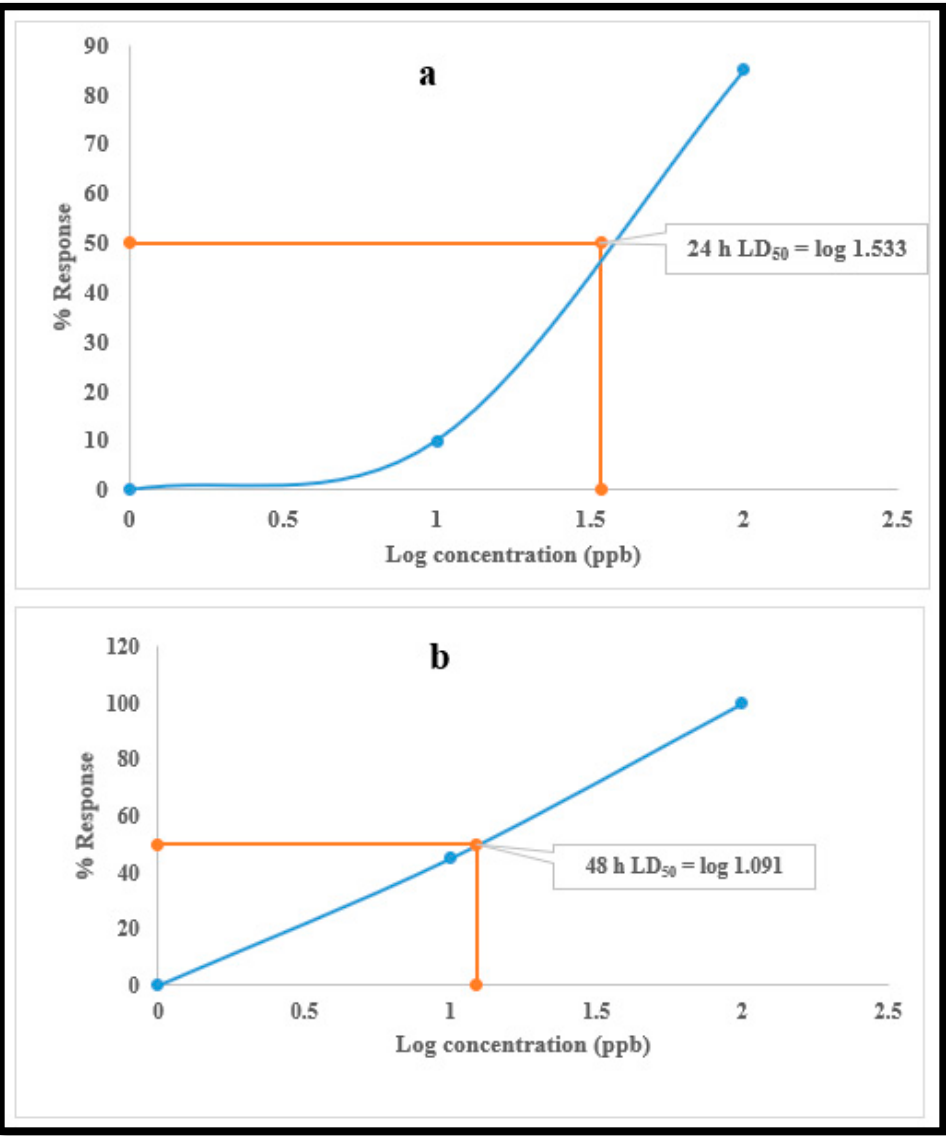
Figure 1. LD50 of lamivudine at; ( a ) 24 h and ( b ) 48